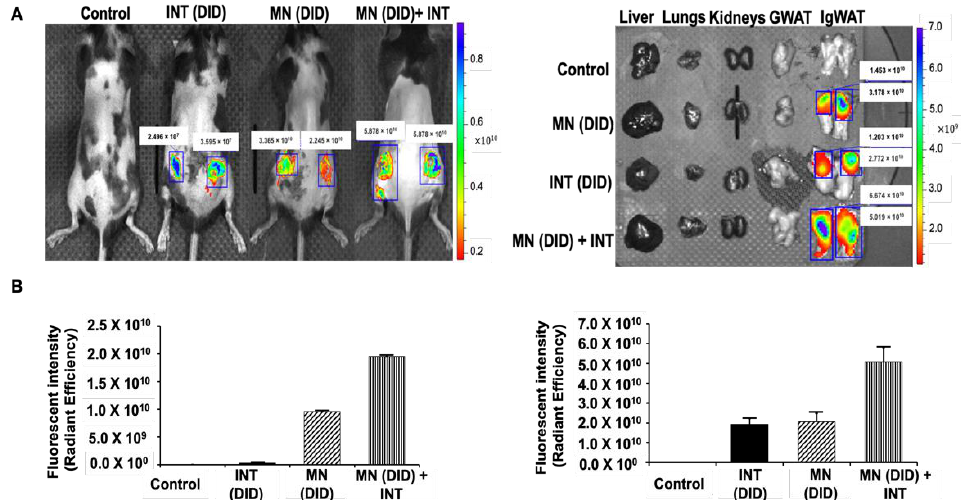
Figure 2. In vivo fluorescence imaging and biodistribution of DID dye using MN patches and INT. IVIS images of ( A ) the biodistribution of DID dye using different treatments: Control, INT (DID) alone, MN (DID) alone, and MN (DID)+ INT in C57BL/6J mice and dissected organs. ( B ) Quantified fluorescence intensity of the delivered DID dye. Images are representatives of three independent experiments. Data were calculated from three independent experiments and expressed as means ± SEM.